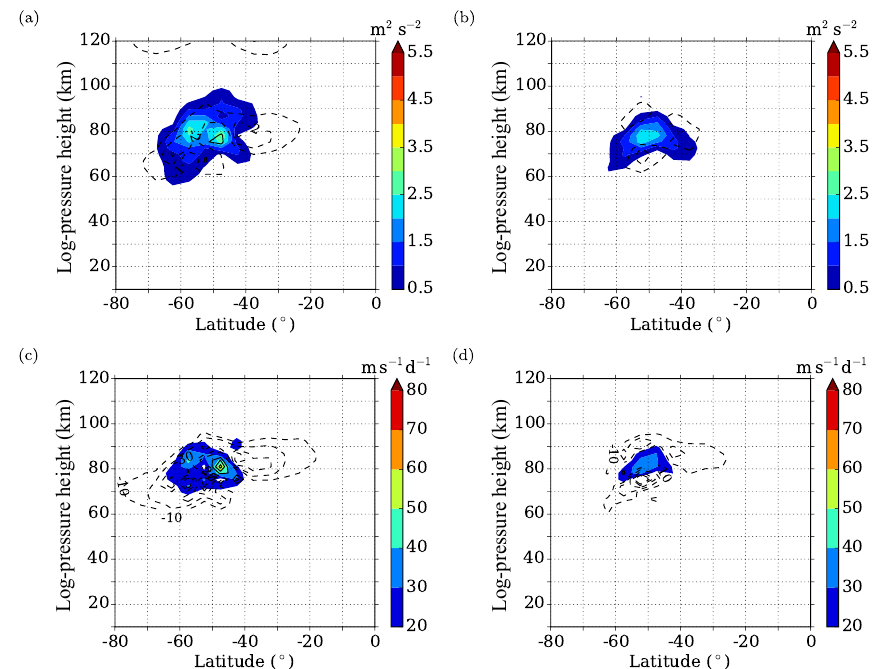
Figure 9. Background colors: Run3 zonal GW flux amplitudes of SPW1 (a) and SPW2 (b) and GW acceleration amplitudes of SPW1 (c) and SPW2 (d) . Run3–Run2 differences are added as isolines in intervals of 1m 2 s − 2 (a, b) and 10ms − 1 d − 1 (c, d) , respectively.